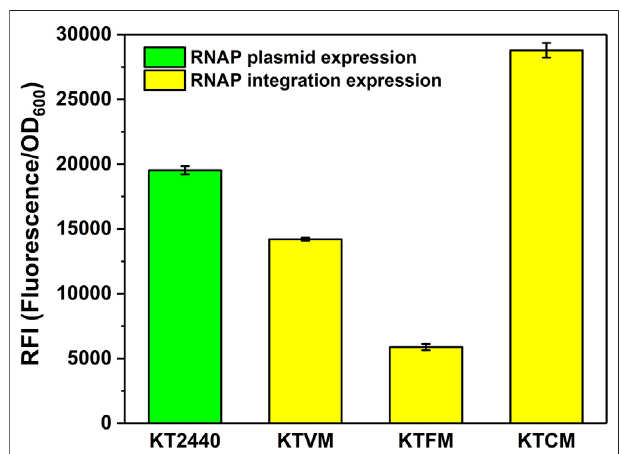
FIGURE 2 | Optimization of the MmP1 RNAP casette integrated into P. putida KT2440 with different integration sites. KT2440: KT2440 harboring the plasmid containing the MmP1 RNAP module and sfGFP with MmP1 promoter; KTVM: KTVM with MmP1 RNAP cassette integrated into vdh site of KT2440 harboring the plasmid containing sfGFP with MmP1 promoter; KTFM: KTFM with MmP1 RNAP cassette integrated into phaC1 site of KT2440 harboring the plasmid containing sfGFP with MmP1 promoter; KTCM: KTCMwithMmP1RNAPcassetteintegratedinto phaF siteofKT2440 harboring the plasmid containing sfGFP with MmP1